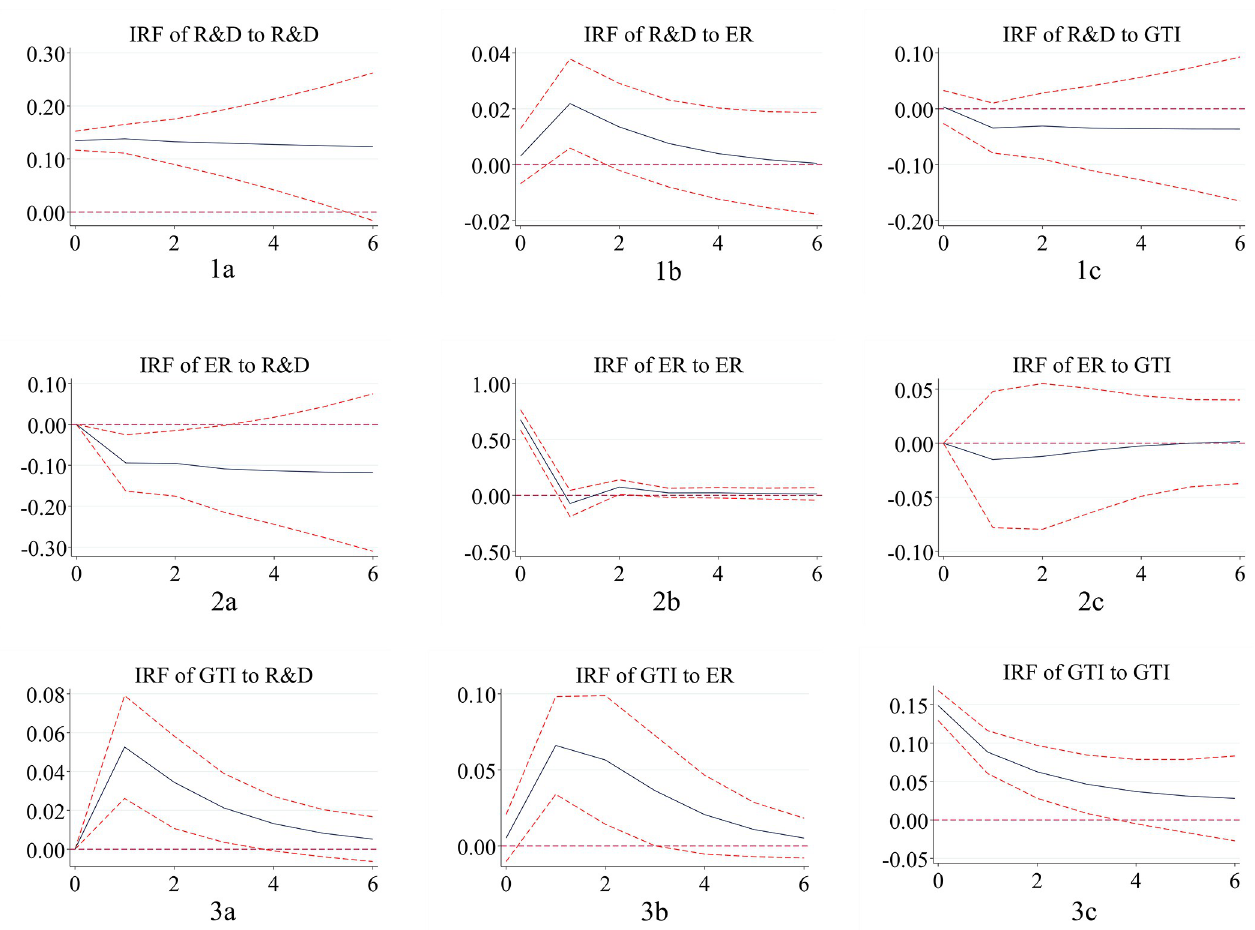
Fig 3. Impulse response in western China. Notes: The horizontal axis represents the number of lag periods (years), the middle curve is the impulse response function curve, and the upper and lower curves represent the 95% confidence interval.